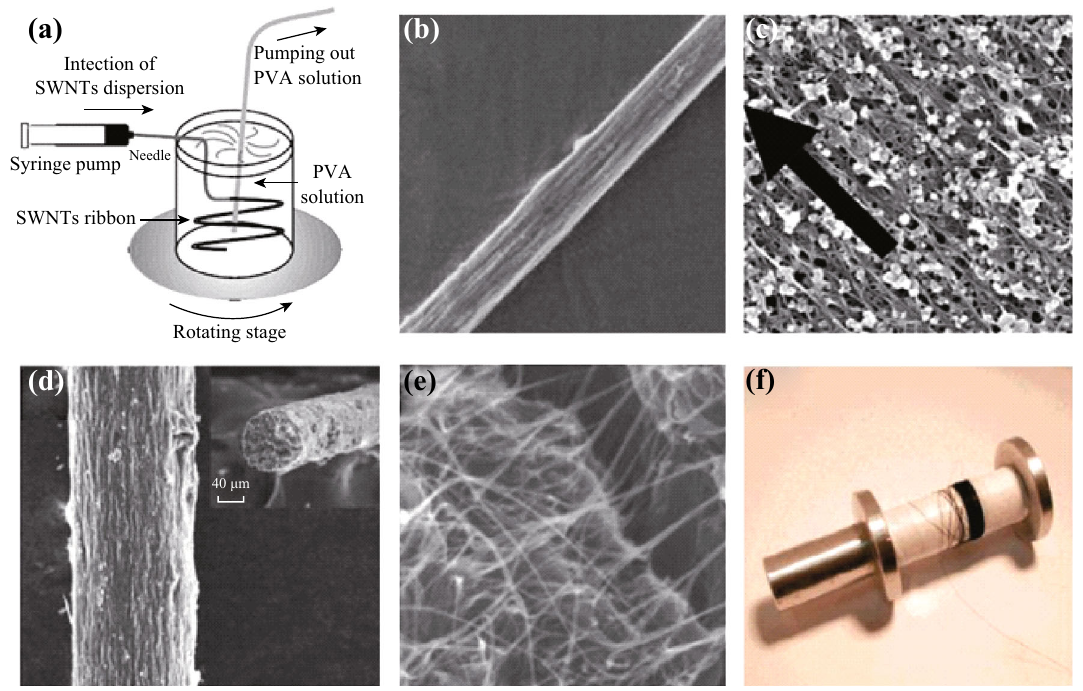
Fig. 1 a Schematic of the experimental setup for spinning CFs using polymer-based coagulation spinning method. SEM images of b a CF and c a ribbon ( black arrow indicates the main axis) deposited on a substrate. SEM images of DNA-SWNT fibers d (The insert image show the round cross section) and e a magnified image of the cross section of an SWNT bundle coated with DNA. f A 10-m-long MWNT fiber collected on a small winder. a – c Reproduced with permission from Ref. [6]. Copyright 2015, American Association for the Advancement of Science. d , e Reproduced with permission from Ref. [8]. Copyright 2008, Wiley–VCH. f Copyright Reproduced with permission from Ref. [11]. Copyright 2005, American Chemical